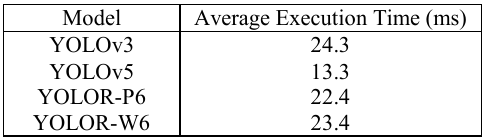
Table 3 . Precision of three